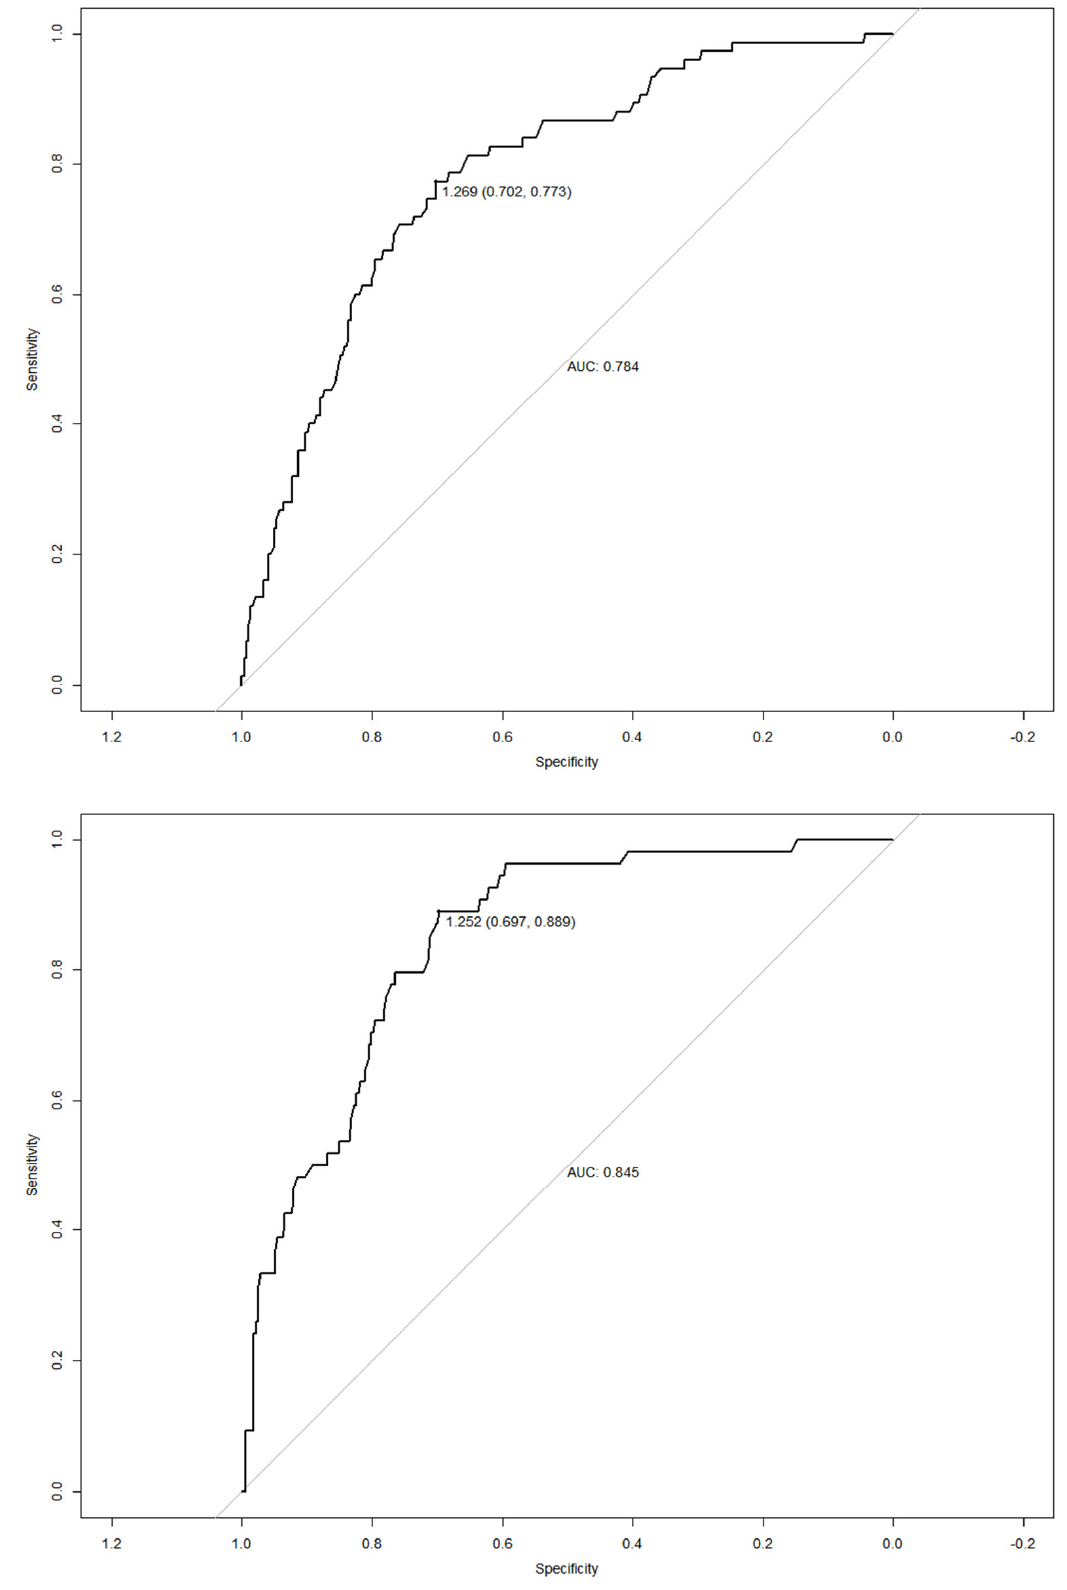
Figure 2. ROC curves of the conicity index for the diagnosis of abdominal obesity in female and male Brazilian rural workers according to the IDF criteria, respectively . AUC—area under the curve.